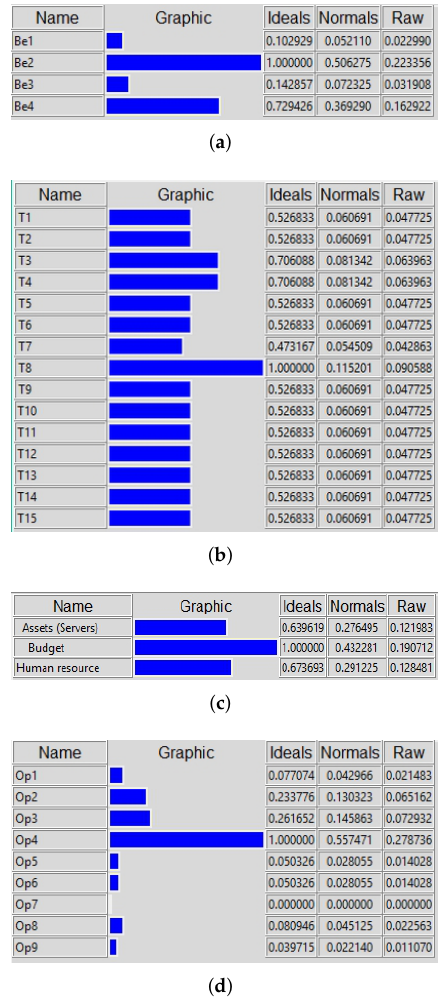
Figure 5. Overall priorities produced by Super Decisions Version 3.2). ( a ) Priorities for the Benefits; ( b ) Priorities for the Threats; ( c ) Priorities for the Resources; ( d ) Priorities for the